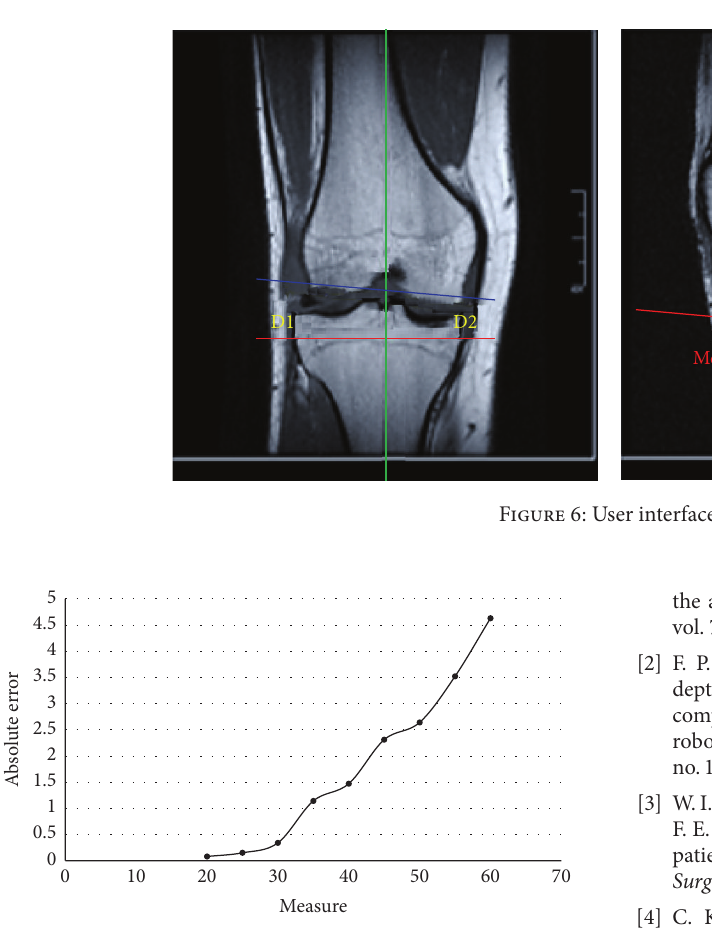
Figure 7: Absolute error of each